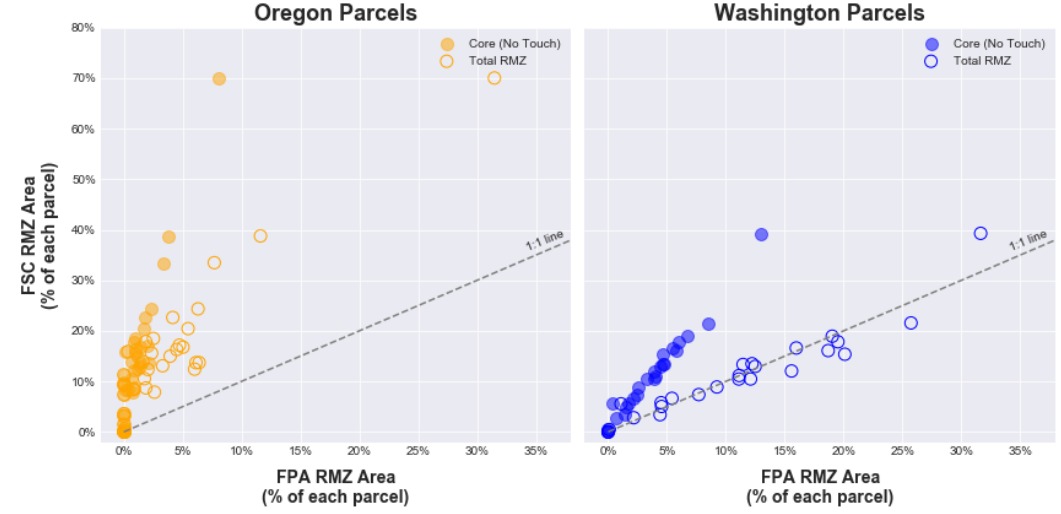
Figure 4. Area encumbered by Riparian Management Zones under FPA and FSC rules for Oregon and Washington. These graphs show the percentage of each parcel that is covered under no-touch/core and total RMZs for both FSC and FPA rules. Points above/below the 1:1 line indicate RMZ buffers cover more/less area under FSC than FPA rules.